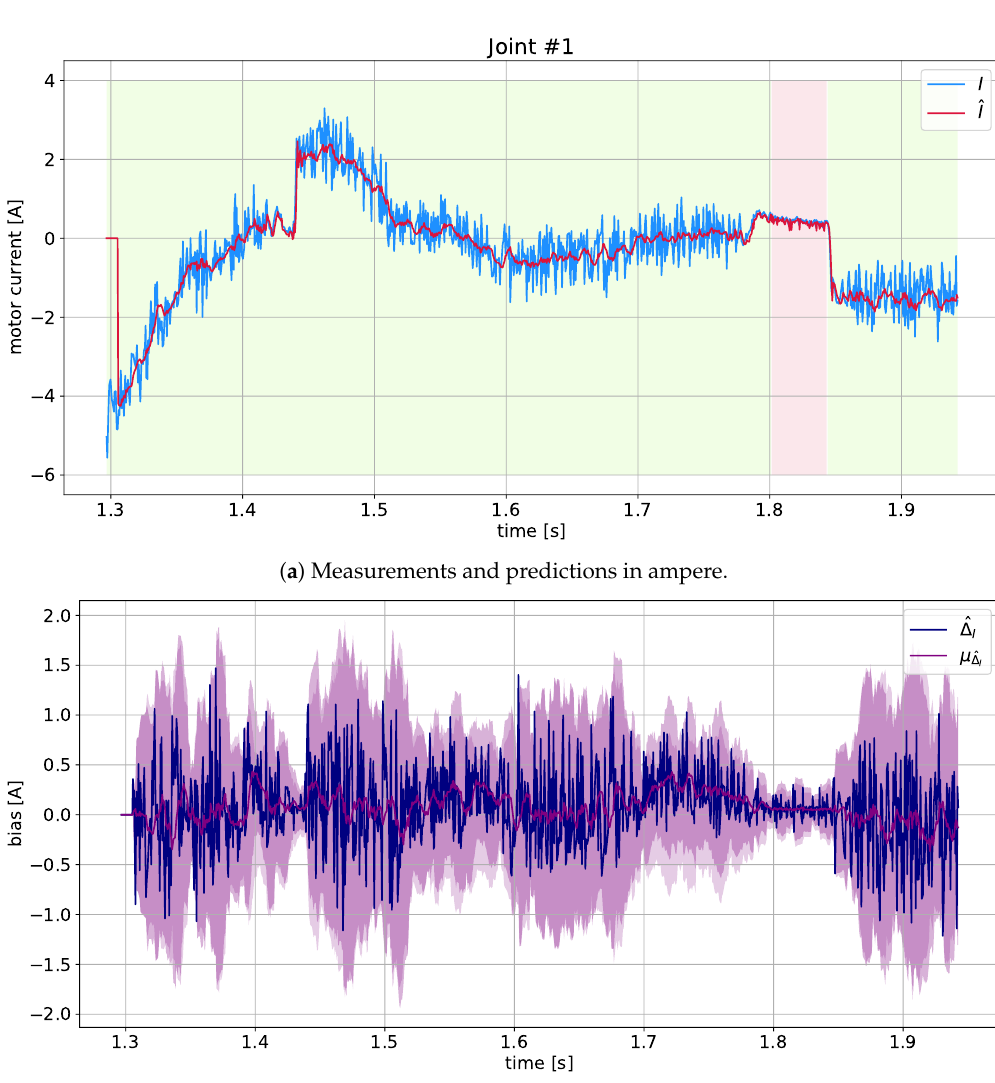
( b ) Motor current prediction error—difference between measurement and prediction (dark blue line)—and its average in ampere (dark purple). The purple shadows represent 2.575829 and 3 σ I levels of standard deviation.